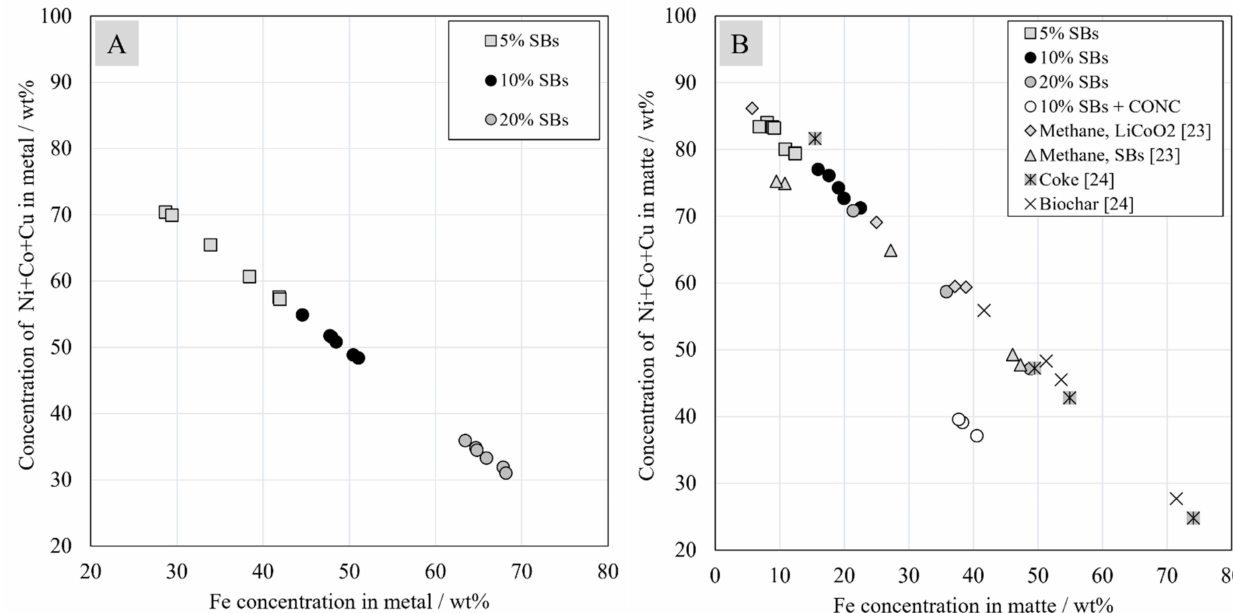
Figure 9. Concentrations of valuable metals (Ni, Co and Cu) in metal ( A ) and matte ( B ) as a function of iron concentration in metal and matte,